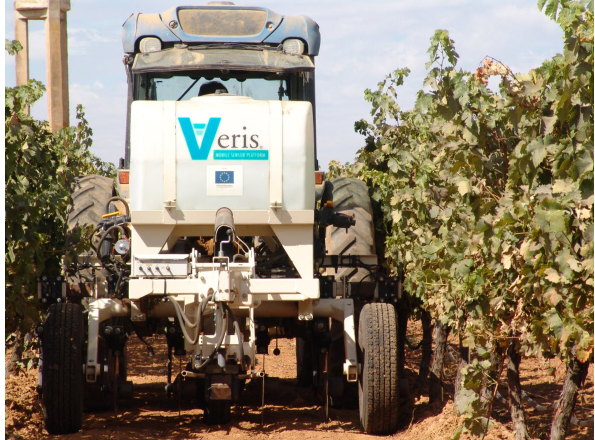
Figure 2. ATV with two multi-spectral sensors for NDVI mapping of vineyard canopy.